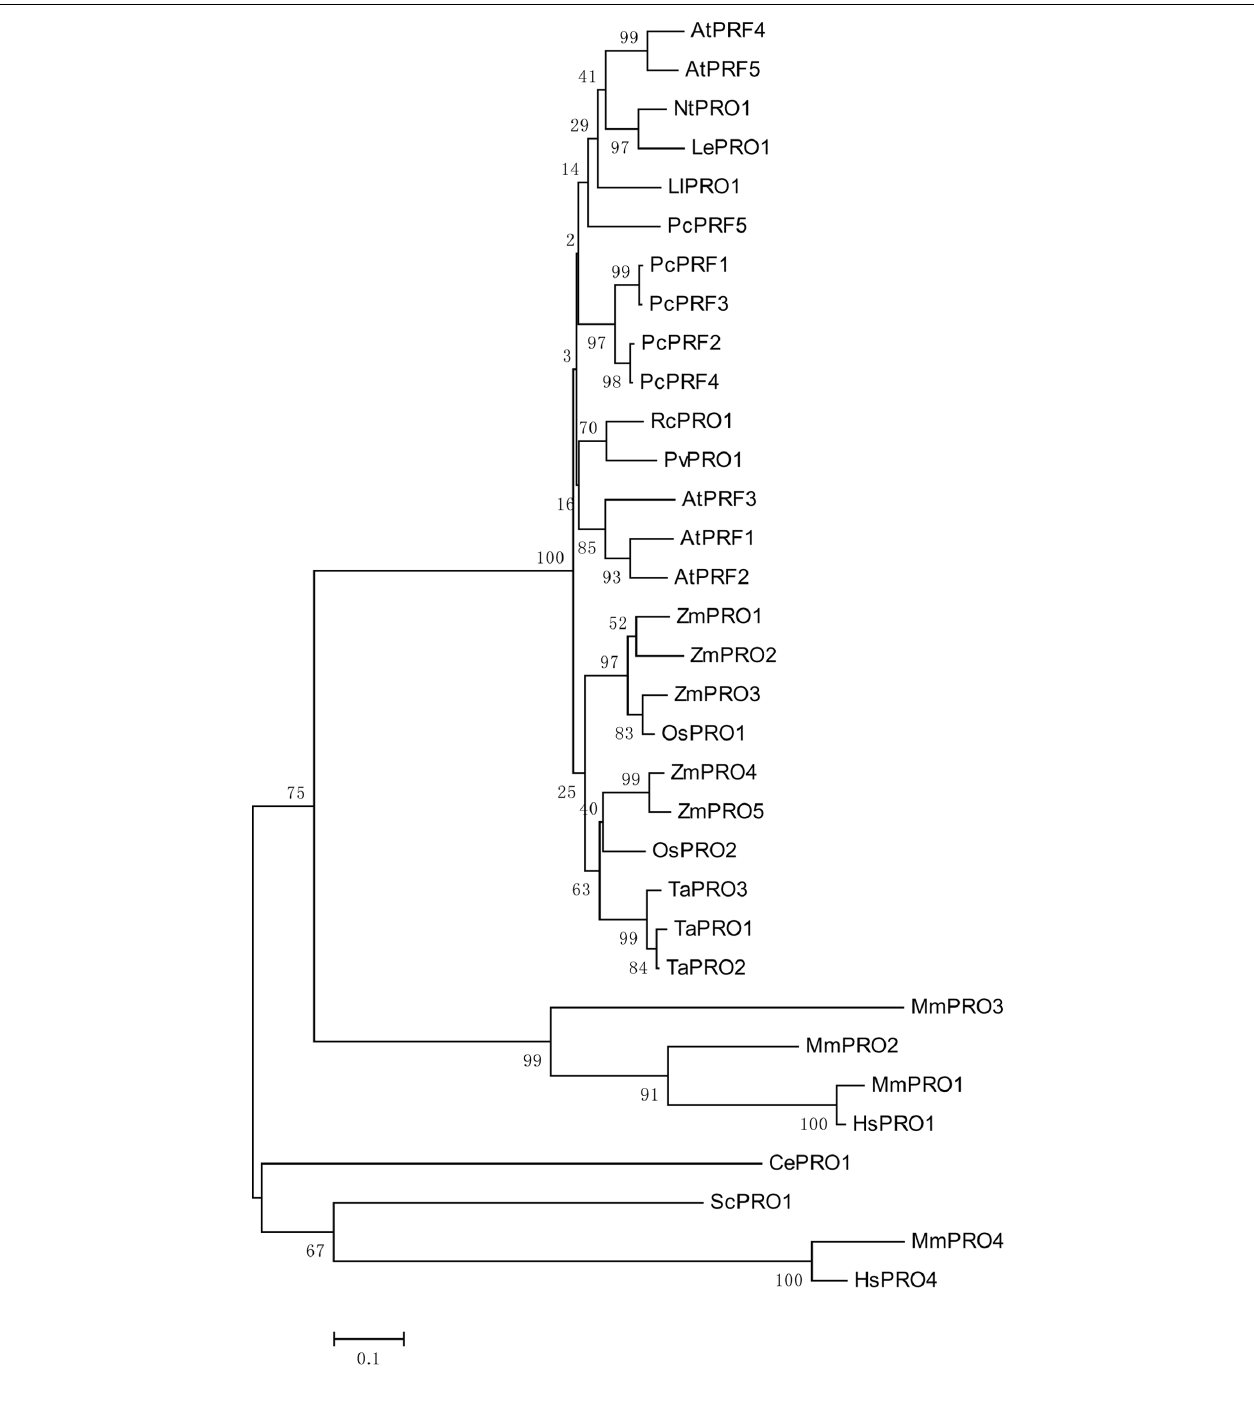
Selected fungal and metazoan sequences are included: Mus musculus MmPRO1–MmPRO4 (NP_035202, NP_062283, NP_083579, AK013595), Homo sapiens HsPRO1 and HsPRO4 (BC057828, BC029523), Caenorhabditis elegans CePRO1 (PFN-1, NP_493258) Saccharomyces cerevisiae ScPRO1 (PFY1, NP_014765).The percentage of replicate trees in which the associated taxa clustered together in the bootstrap test (1000 replicates) is shown next to the branches (Felsenstein, 1985).The tree is drawn to scale, with branch lengths in the same units as those of the evolutionary distances used to infer the phylogenetic